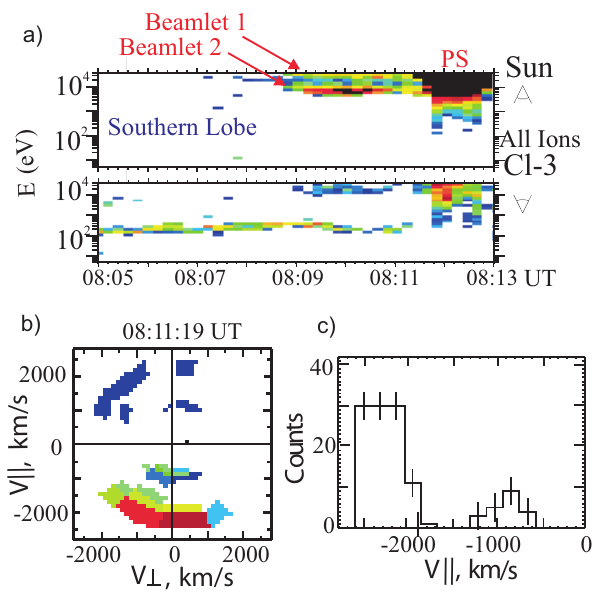
Fig. 25. Cluster observation of “double-peaked” ion distributions in the PSBL on March 9, 2001. E − T spectrograms of Earthward and tailward moving ions obtained by Cluster/HIA (a) . 2-D (cut in V k – V ⊥ plane, b ) and 1-D (cut along magnetic field, c ) 12s accumulated ion distribution. (From Zelenyi et al.,